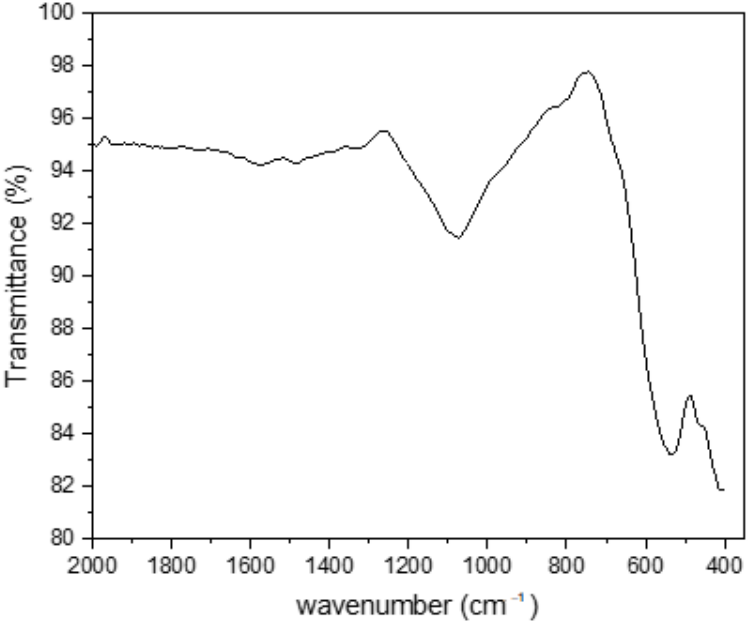
Figure 1. Fourier-transform infrared (FTIR) spectra of LCF.